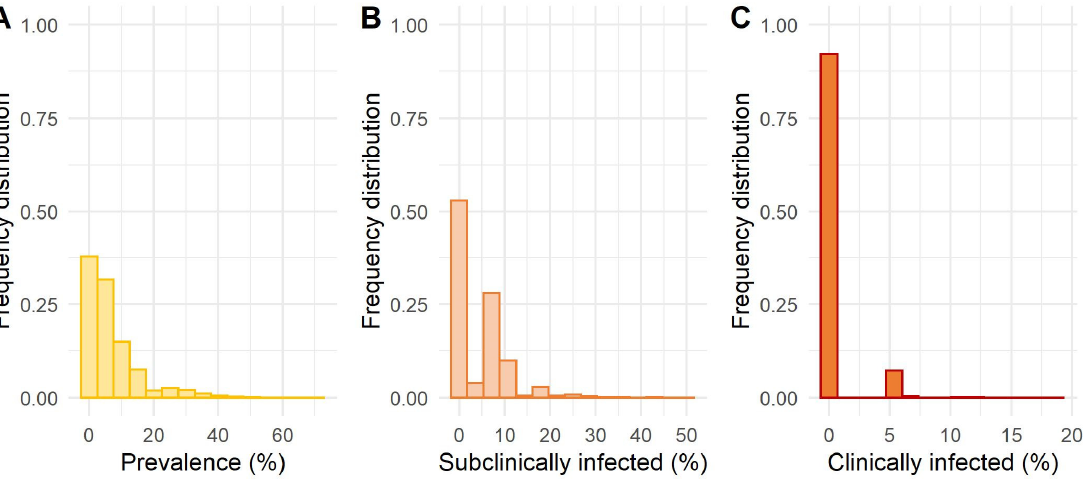
Figure 4. Frequency distribution of ( A ) the prevalence of Mycobacterium avium subsp. paratuberculosis within the herd and ( B ) the proportions of subclinically infected cows and ( C ) clinically infected cows.